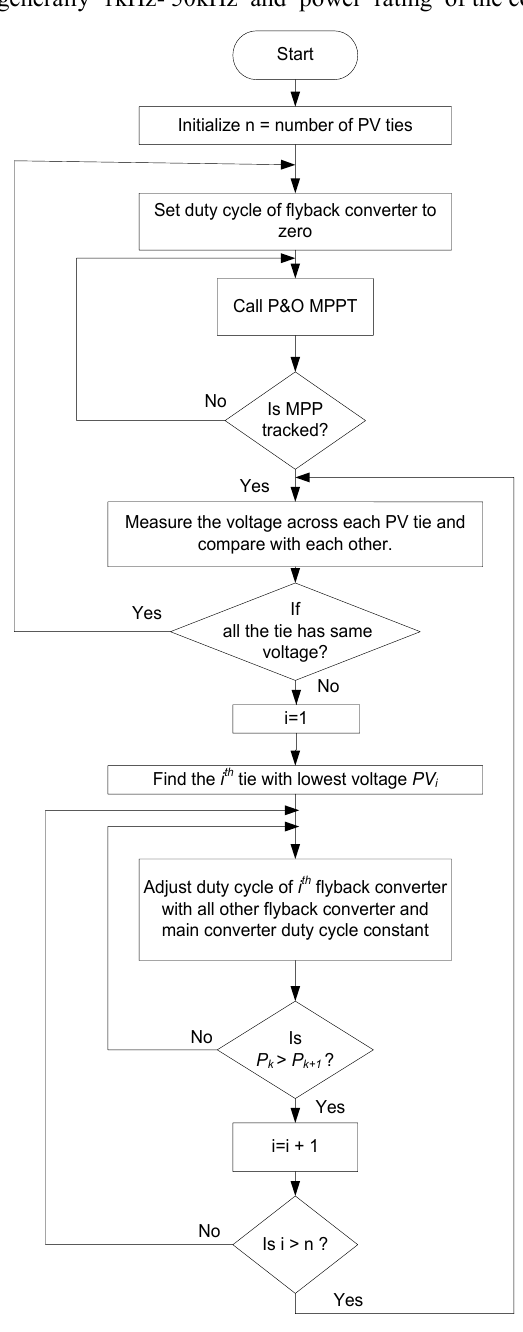
Fig. 2 Algorithm of TCT-CC method for